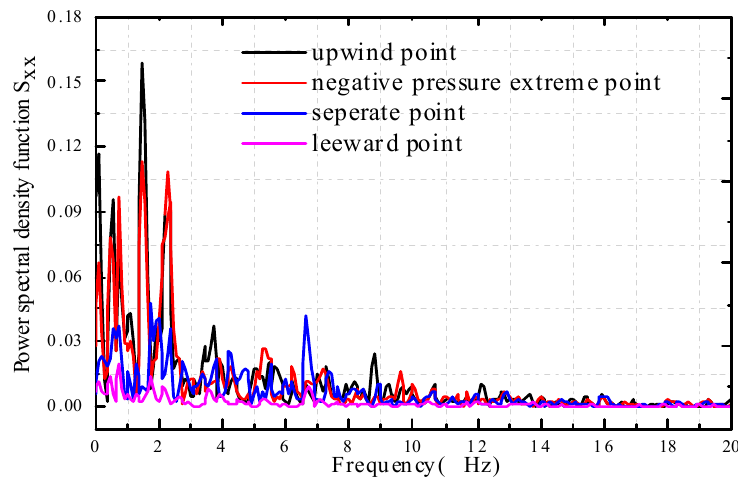
( d ) Leeward side Figure 3. Time history of pressure coefficient at representative measuring points of the built-up tower.